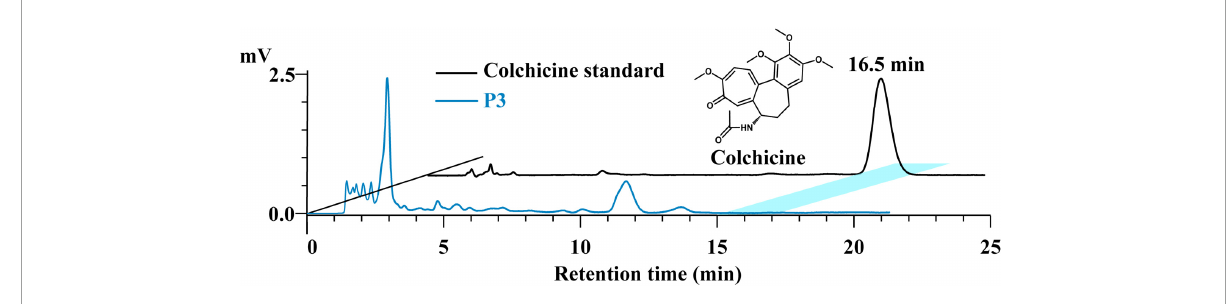
FIGURE5 HPLC analysis of the colchicine in the Lilii Bulbus soup prepared by process 3. P3, Process